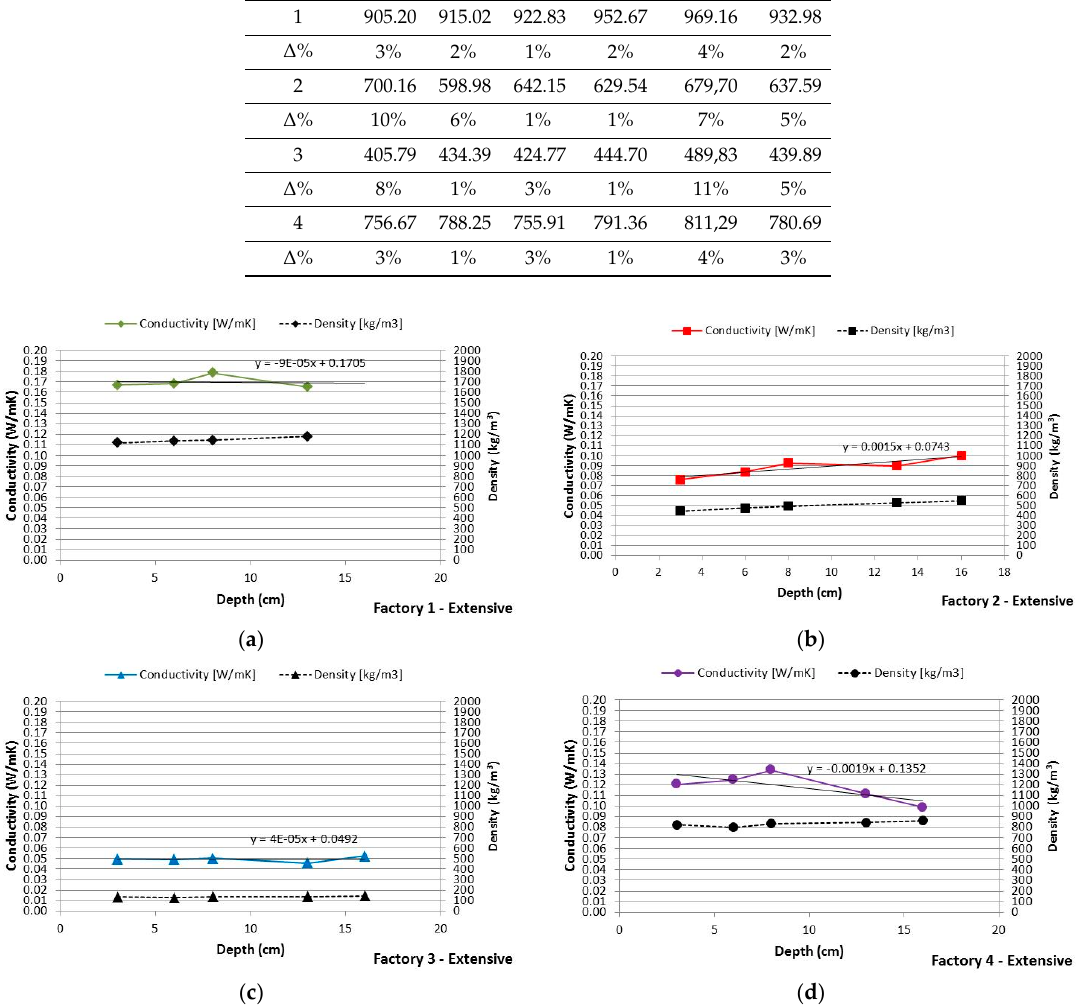
Figure 4. Dry thermal conductivity—extensive samples; ( a ) Factory 1, ( b ) Factory 2, ( c ) Factory 3, ( d ) Factory 4.